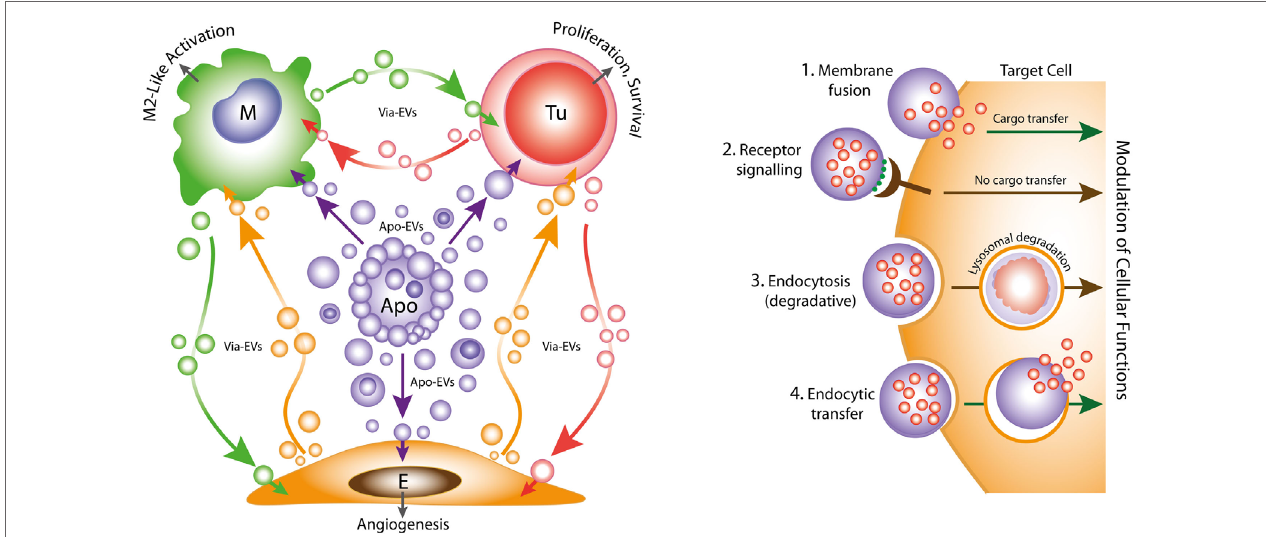
FiGUre 1 | Left: oncogenic extracellular vesicle (EV) networks in the onco-regenerative niche (ORN). Schematic representation of the ORN illustrating the potential roles of Apo-EVs from dying tumor cells (Apo) in providing oncogenic signals to neighboring cells in the niche, exemplified by macrophages (M), viable tumor cells (Tu), and endothelial cells (E). We propose that Apo-EVs target such cells and modulate cellular functions, including macrophage polarization toward a reparative phenotype (M2-like activation state), promotion of tumor cell survival and proliferation, and angiogenesis. EVs from viable cells (Via-EVs) of tumor and stromal cell origin also seem likely to participate in these processes. Right: mechanisms of cell targeting and modulation by (Apo)-EVs. Examples of possible modes of interaction of Apo-EVs with target cells that may lead to modulation of cellular functions with or without transfer of intact EV cargoes (biologically active cargoes represented by small red circles). 1. Membrane fusion (receptor-dependent or -independent) permits transfer of EV cargoes to cytosolic locations. 2. Docking of EVs through receptor–ligand interaction may activate intracellular signaling pathways in the absence of cargo transfer. Ligands such as phosphatidylserine (PtdSer) (green) exposed at EV surfaces may interact directly or indirectly with target cell receptors (examples in the case of PtdSer including BAI1, TIM-4, Stabilin 2, Axl, Mer, as well as integrins α v β 3 and α v β 5). 3. Endocytic pathways (including phagocytosis) resulting in lysosomal degradation of cargoes are also likely to modulate cellular functions such as through metabolite supply and via receptor ligation. 4. Putative endocytic uptake of EVs without lysosomal degradation. We propose that Apo-EV cargoes are transferred intact to multiple intracellular compartments via this type of